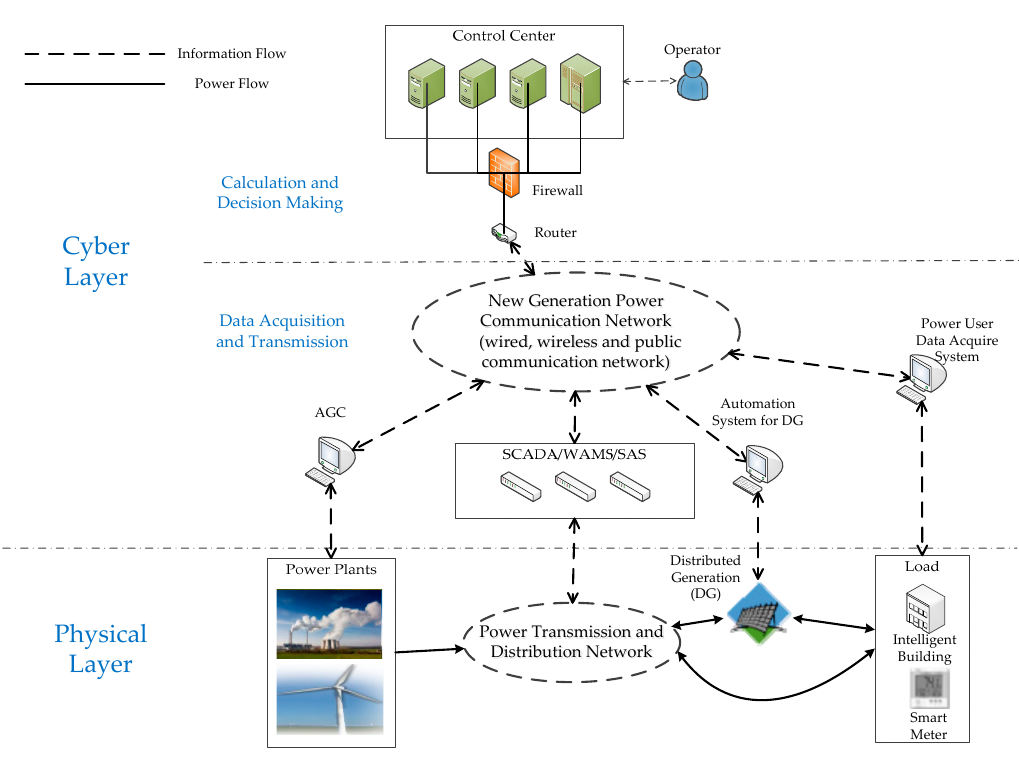
Figure 1. A typical structure of a CPPS.